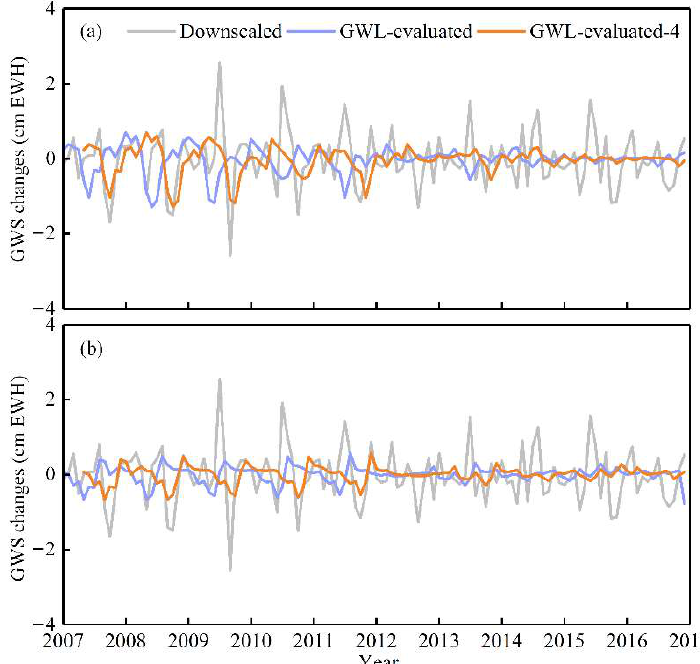
Figure 11. Comparison of GWS changes from downscaled and field observations in ( a ) WWB and ( b ) MQB. GWL-evaluated and GWL-evaluated-4 represent GWS changes of field observations at the current month and 4-month time lag, respectively.